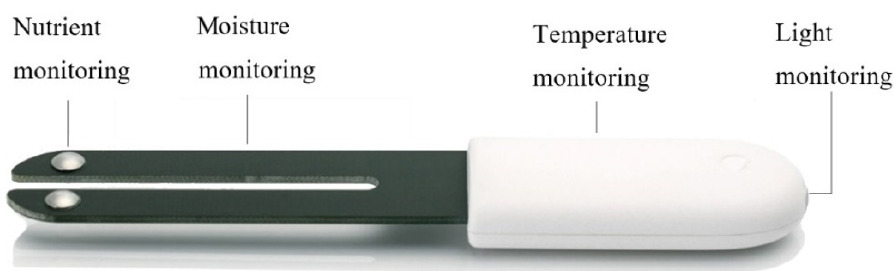
Figure 4. Xiaomi sensor. Table 2. Parameters of the Xiaomi sensors.